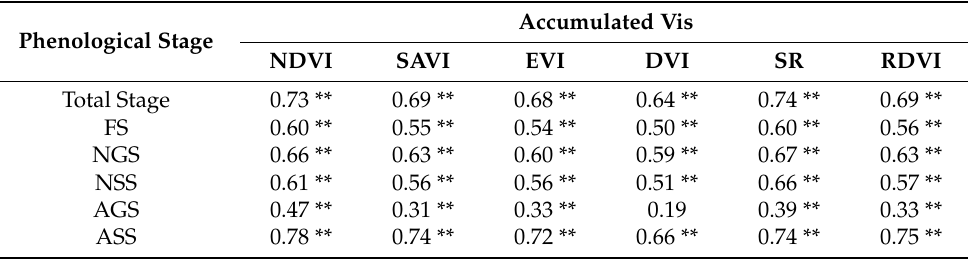
Table 3. Correlation analysis between yield and ∑ Vis at different phenological